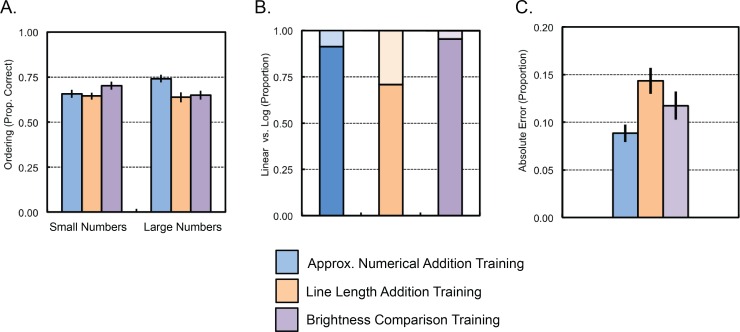
Number line placement test performance by children in the three training conditions of Experiment 2.(A) Accuracy in ordinality of children's placements. (B) Proportion of children with more linear placements (dark portion of bars) and with more logarithmic placements (lighter portion of bars). (C) Proportion of error in children’s placements, with smaller values corresponding to better performance.